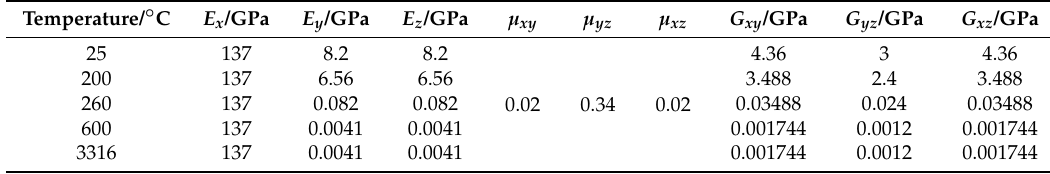
Table 1. Mechanical properties of IM600/133 composite